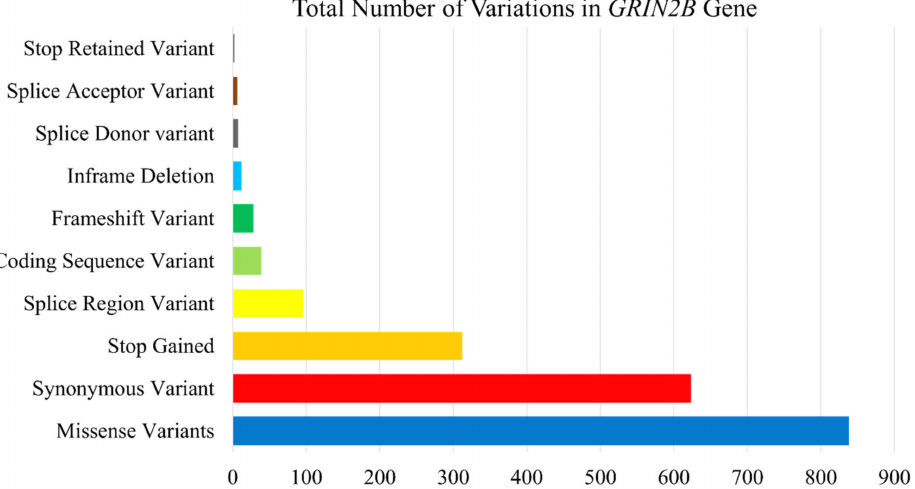
Figure 1. Classification of the total number of variations in the GRIN2B based on their locus. Table 1. Impact of changes in GRIN2B due to amino acid substitution predicted by SIFT, Polyphen2, SNAP2, CADD, REVEL, MetaLR, and Mutation